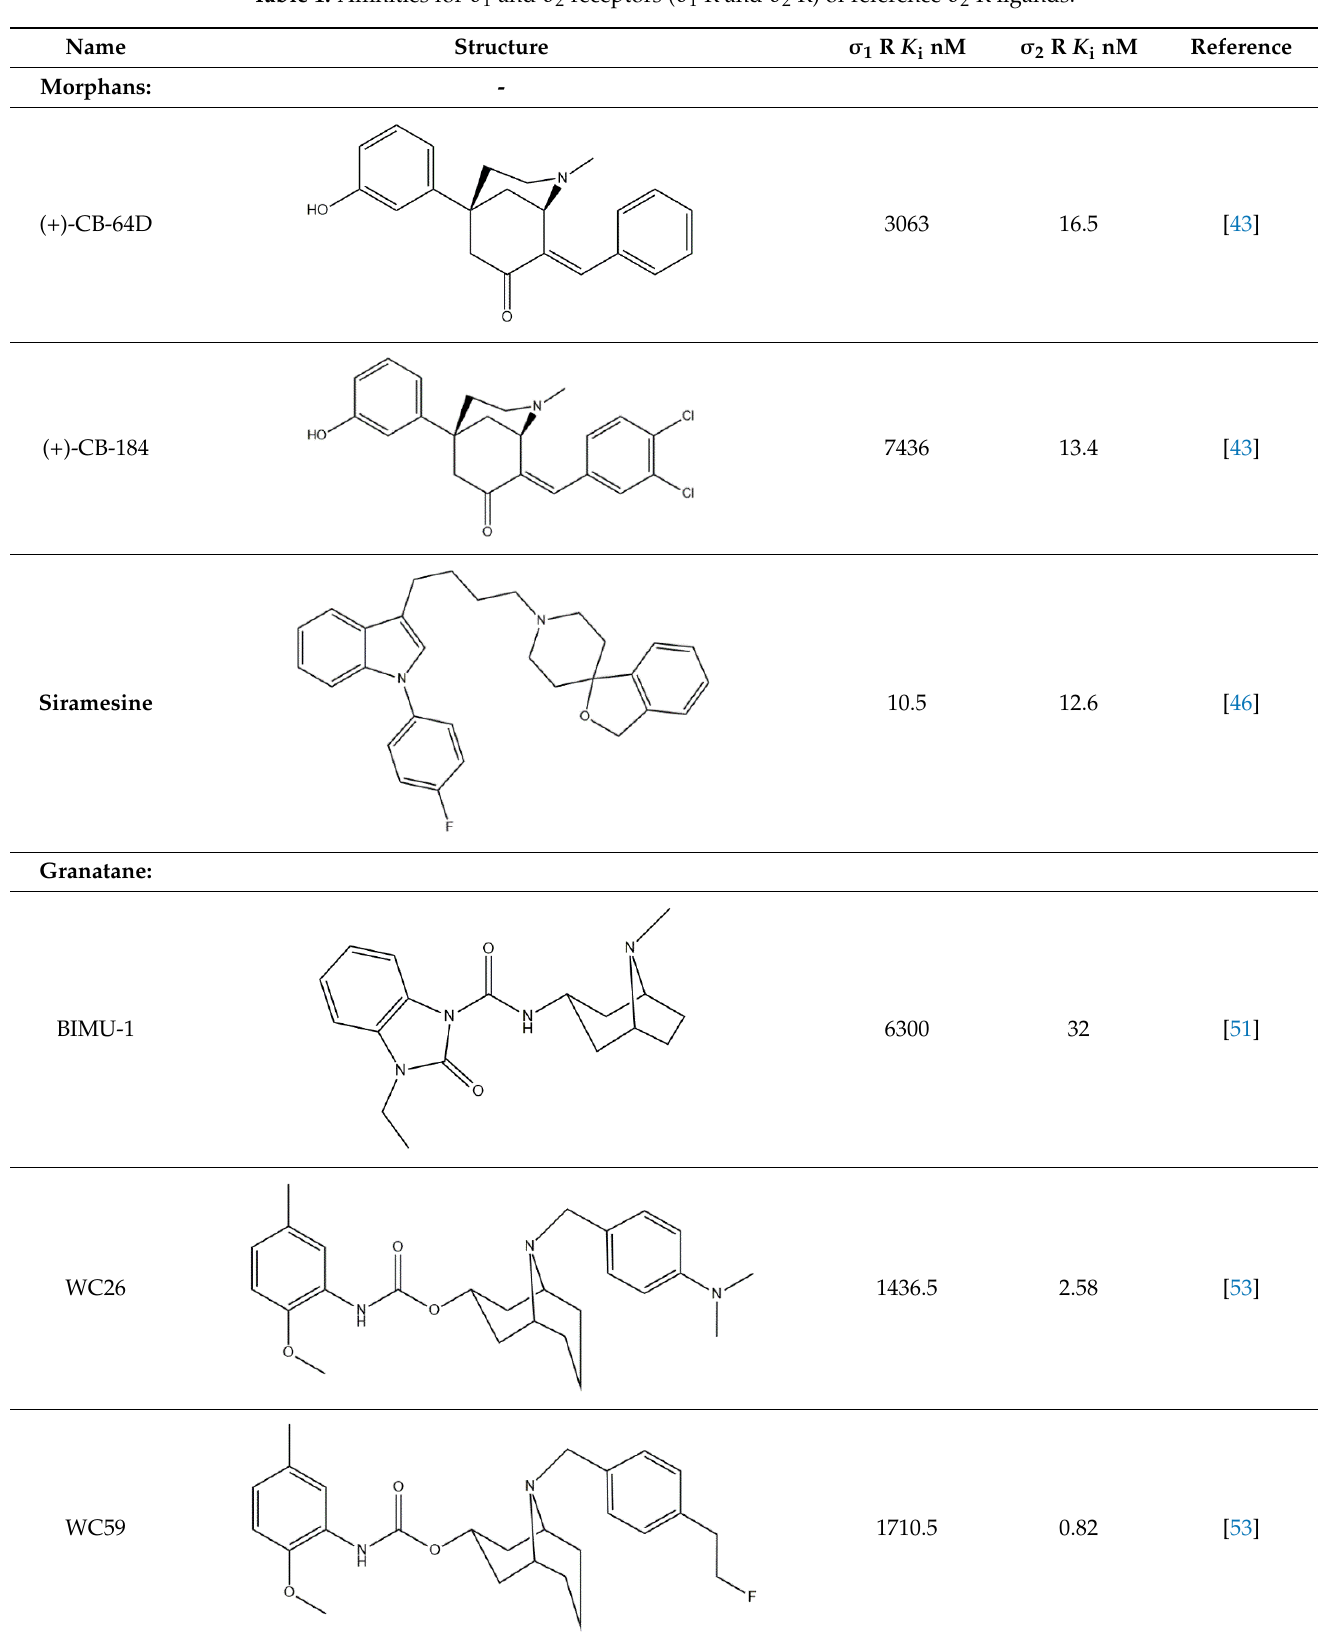
Table 1. Affinities for σ 1 and σ 2 receptors (σ 1 R and σ 2 R) of reference σ 2 R ligands.